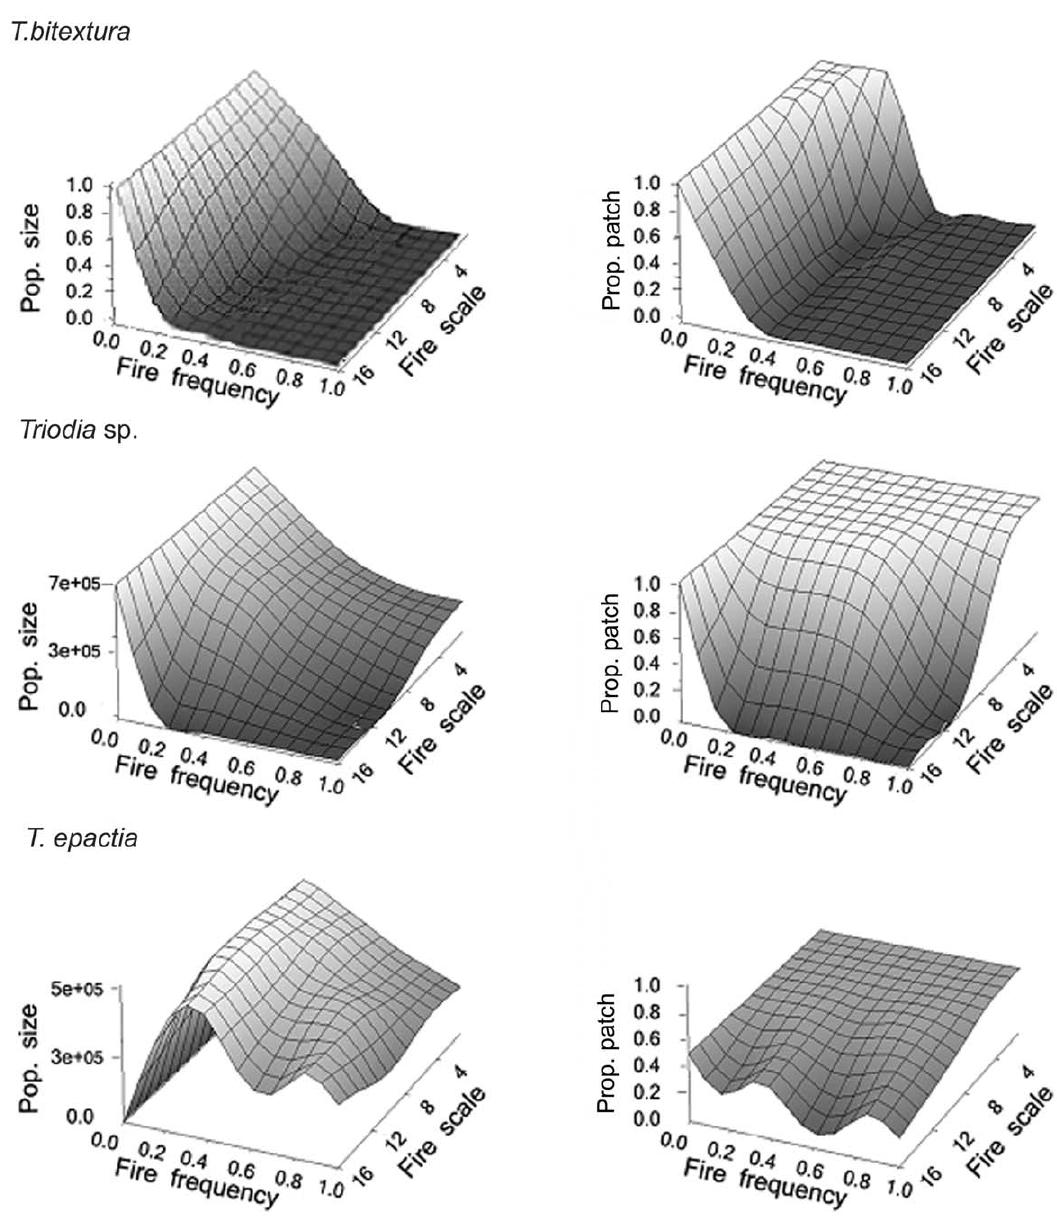
Figure 1. The mean population size (max. 1 million) and proportion of patches occupied (1=100%) at different fire frequencies and scales over the entire ‘landscape’ for individual species without competition.